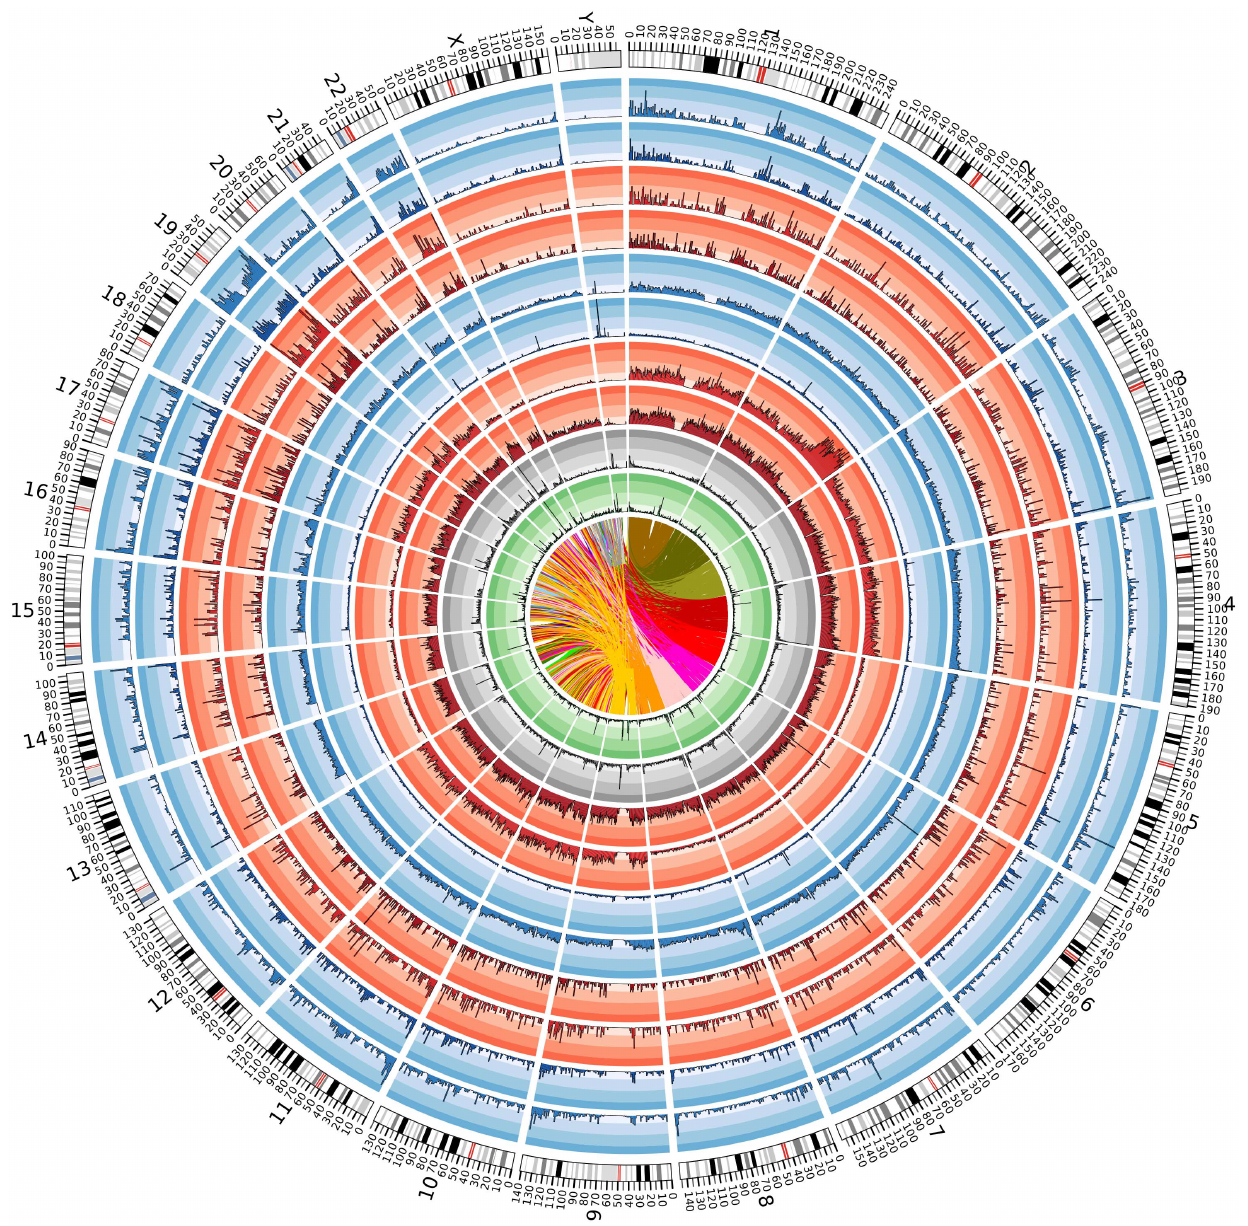
Figure 7. Summary of analysis of genomes from Kuwait subgroup of Saudi Arabian tribe ancestry. Tracks (from outer to inner): Karyotype of Human Genome; Density (in every window of 1 Mb) of ‘known’ SNPs (i.e. annotated in dbSNP 137) from the UE data set; Density of ‘novel’ SNPs (i.e. not annotated in dbSNP137) from the UE data set; Density of ‘known’ indels from the UE data set; Density of ‘novel’ indels from the UE data set; Density of ‘known’ SNPs from the UW data set; Density of ‘novel’ SNPs from the UW data set; Density of ‘known’ indels from the UW data set; Density of ‘novel’ indels from the UW data set; Density of long Indels; Density of duplications, inversions and tandem duplications; Links representing intra- and inter-chromosomal translocations. The image was generated using Circos [71].